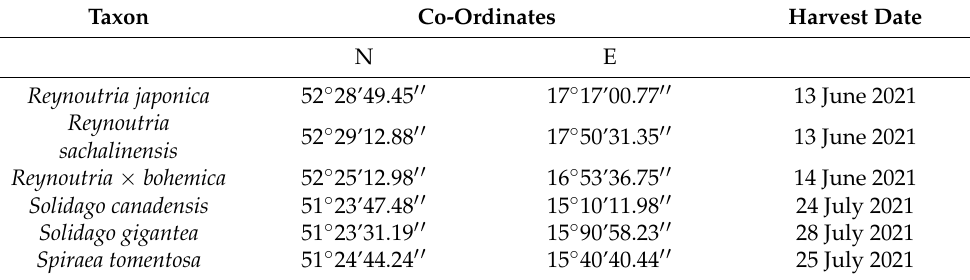
Table A1. Plant stands from which the samples for research were